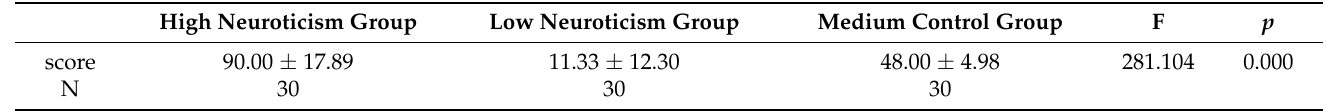
Table 3. Group validity test. ( M ± SD ; Unit: